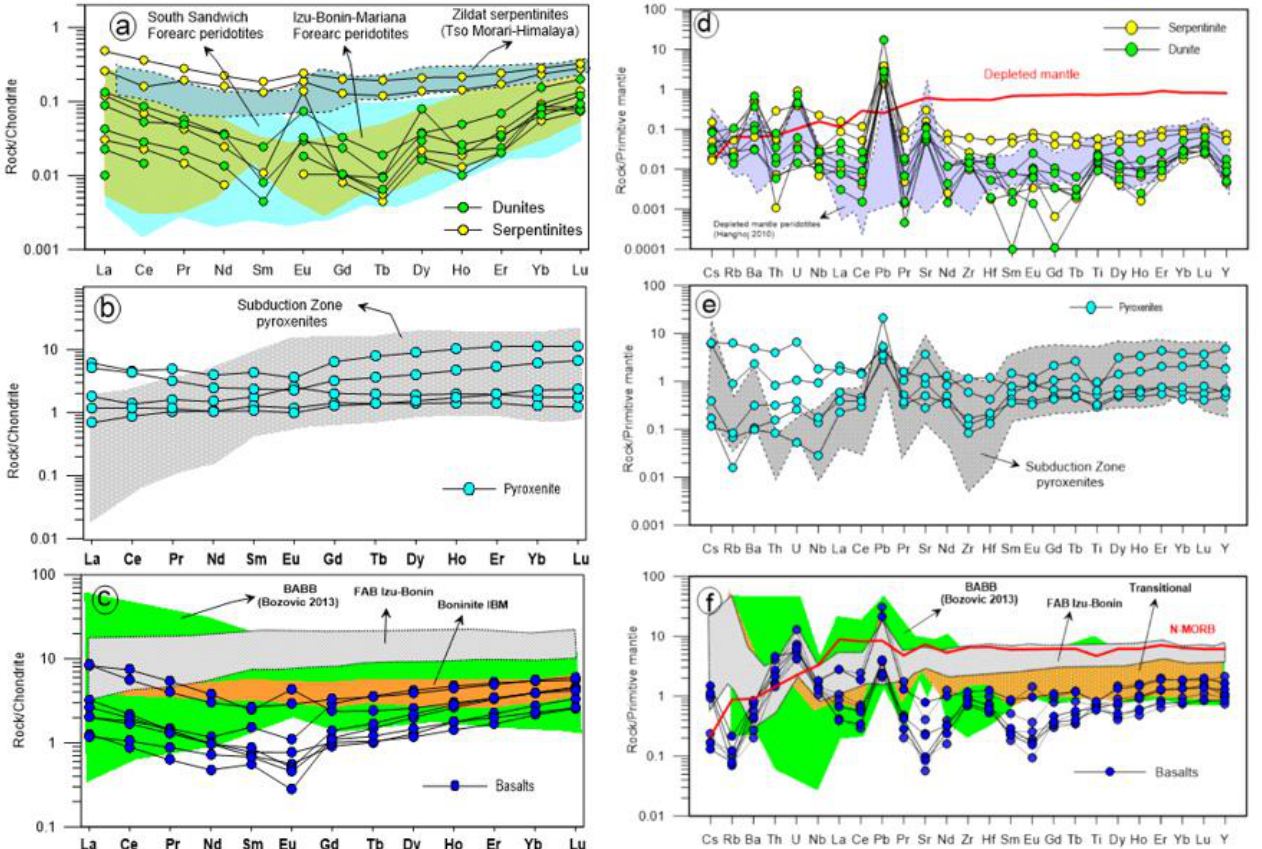
Figure 6. Rare-earth and trace element spider diagrams for different lithologies of the WOC. ( a – c ) Chondrite normalized [45,49] REE patterns; ( d – f ) primitive mantle normalized [45,49] extended trace elements ’ spider diagrams for the studied peridotites, pyroxenites, and basalts. Elements are arranged in terms of increasing compatibility (from left to right) in a peridotite – basaltic melt system [60]. Fields of Izu – Bonin – Mariana [10], South Sandwich forearc peridotites [57], Zidat forearc mantle wedge serpentinites [58], depleted mantle peridotites [59], subduction zone pyroxenites [61], back-arc basin basalts (BABB) [62], forearc basalts (FAB) Izu-Bonin, transitional, and boninite rocks of Mirdita ophiolite [63], and boninites [64] are shown for comparison. High-field-strength elements (HFSE; Th, U, Nb, Ta, Zr, Hf, and Ti) are some of the